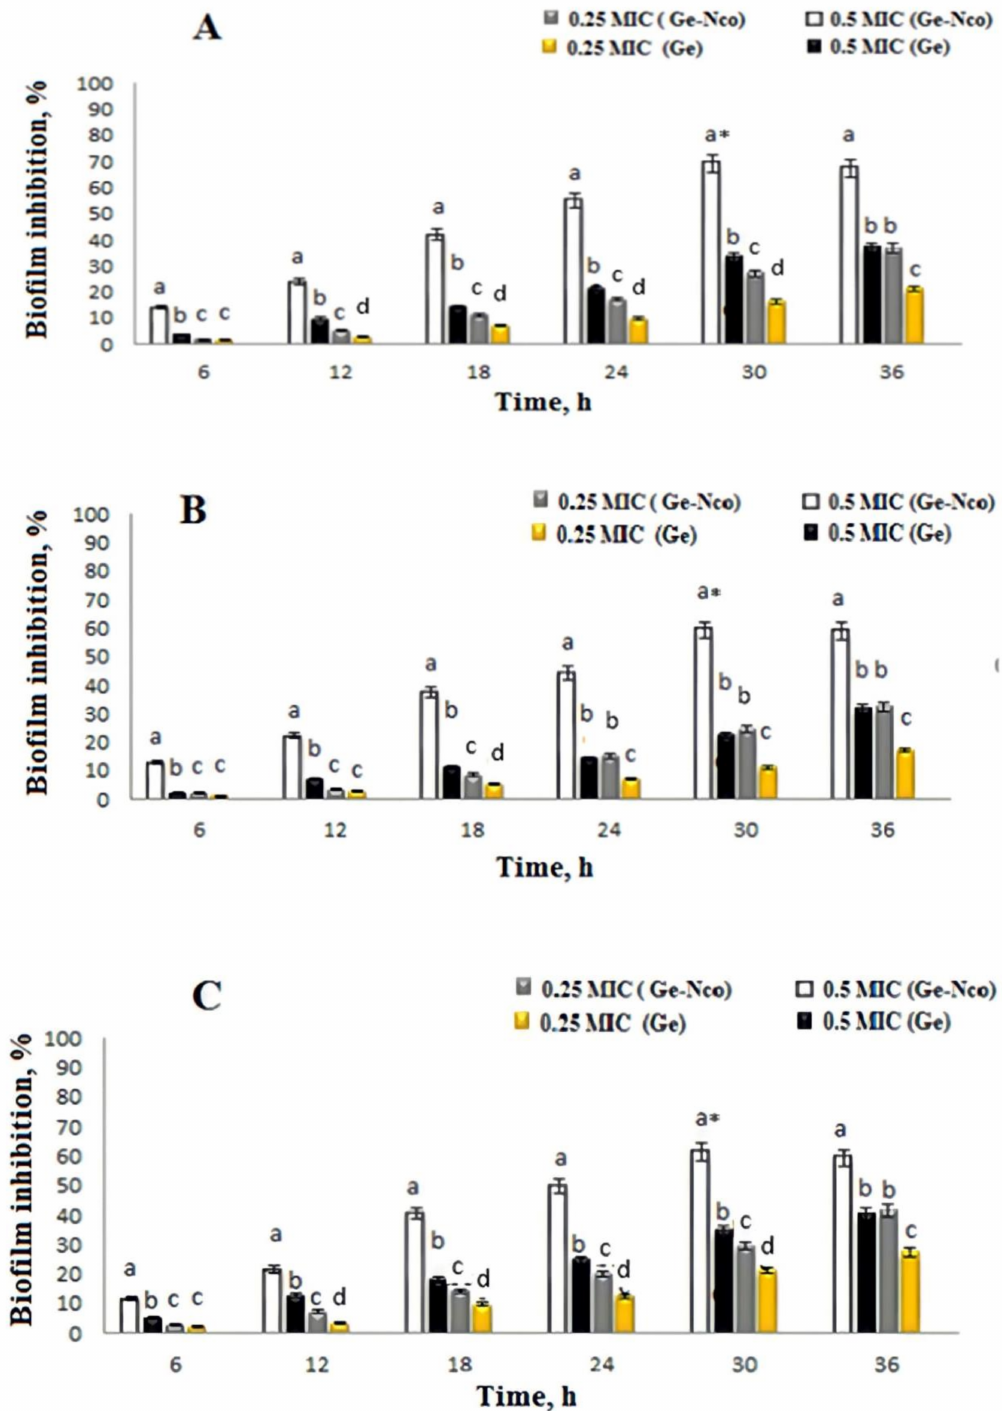
Figure 4. Different letters represent the significance between Inhibition of biofilm after the exposure of 0.5 MIC and 0.25 MIC concentrations of Ge and green nanocomposite-based biopolymers (Ge-Nco) on Candida parapsilosis ( A ), C. tropicalis ( B ), and C. albicans ( C ), respectively at each time of incubation. * denote the highest biofilm inhibition recorded after 30 h of incubation which significantly different (Holnm–Sidak’s test, BI = 68%, p = 0.001). a, b, c and d indicate the significant difference p < 0.05, p < 0.01, p < 0.005 and p < 0.001,